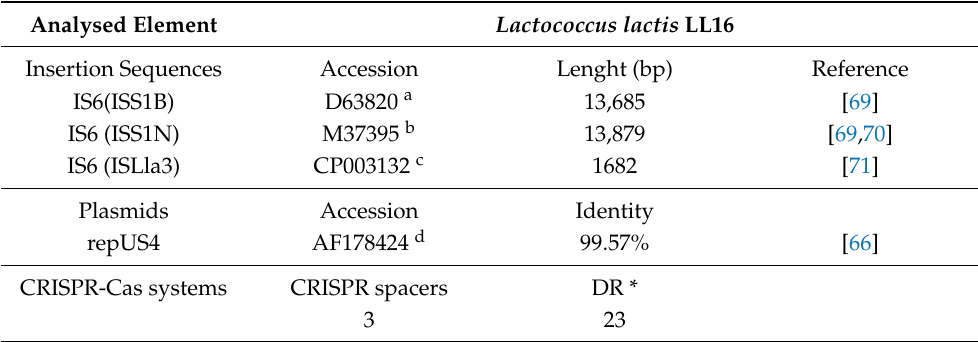
Table 1. Mobile genetic elements (insertion sequences and plasmids) and CRISPR-Cas systems identified with tools MGEFinder and CRISPRFinder in the genome of L. lactis LL16. Analysed Element Insertion Sequences